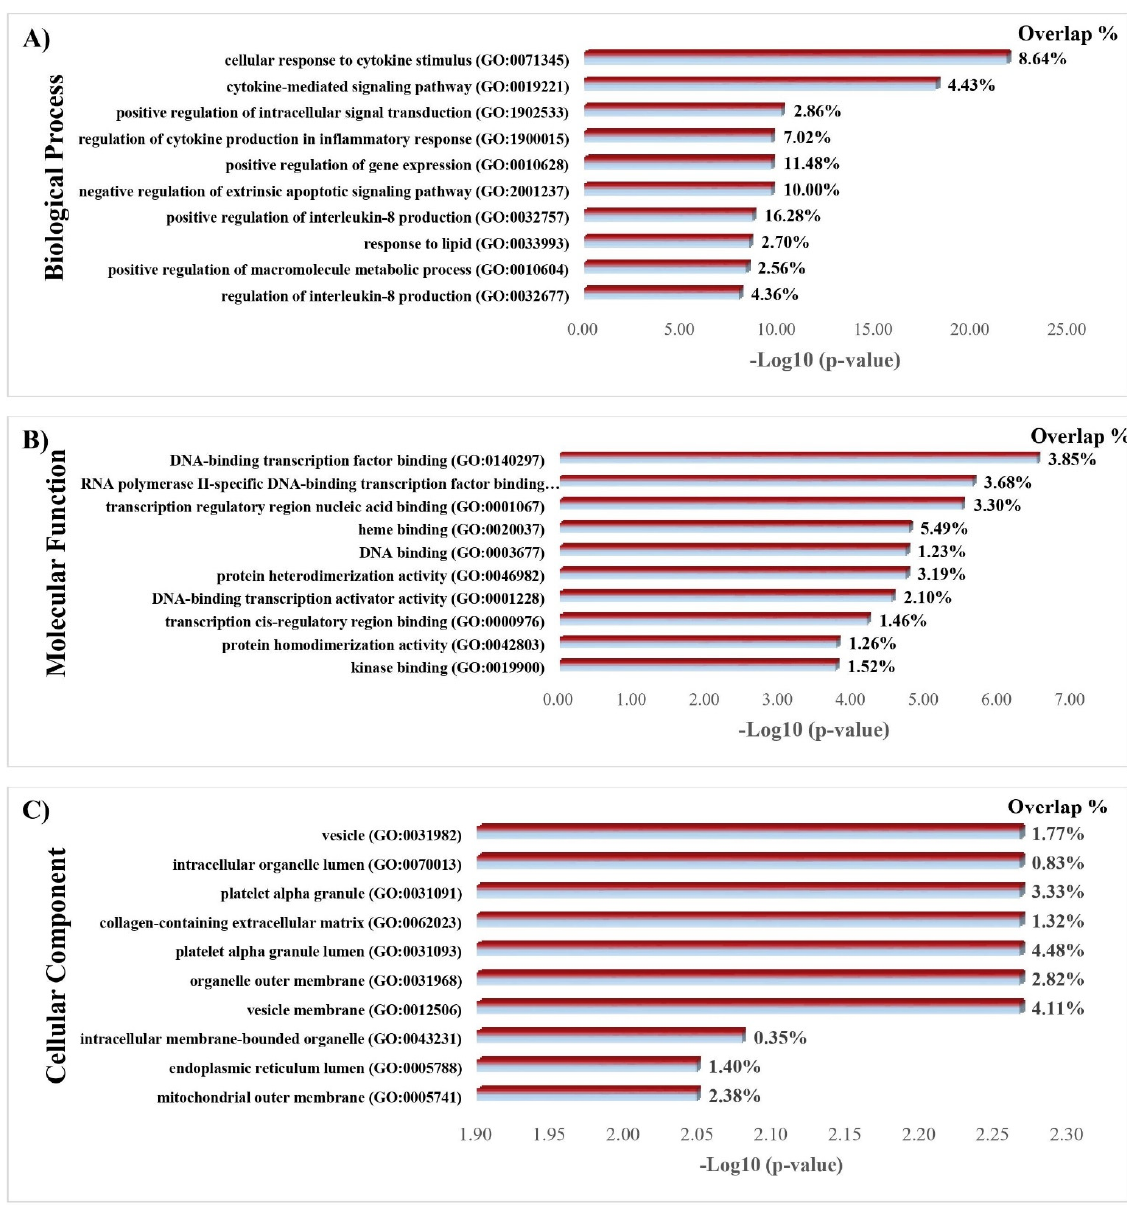
Figure 7. Gene ontology enrichment analysis of 35 shared protein targets (All genes associated with diabetes ∩ curcumin targets) using the Enrichr algorithm. ( A ) Ten highest adjusted p -value Biological process; ( B ) Ten highest adjusted p -value Cellular compound; ( C ) Ten highest adjusted p -value Molecular